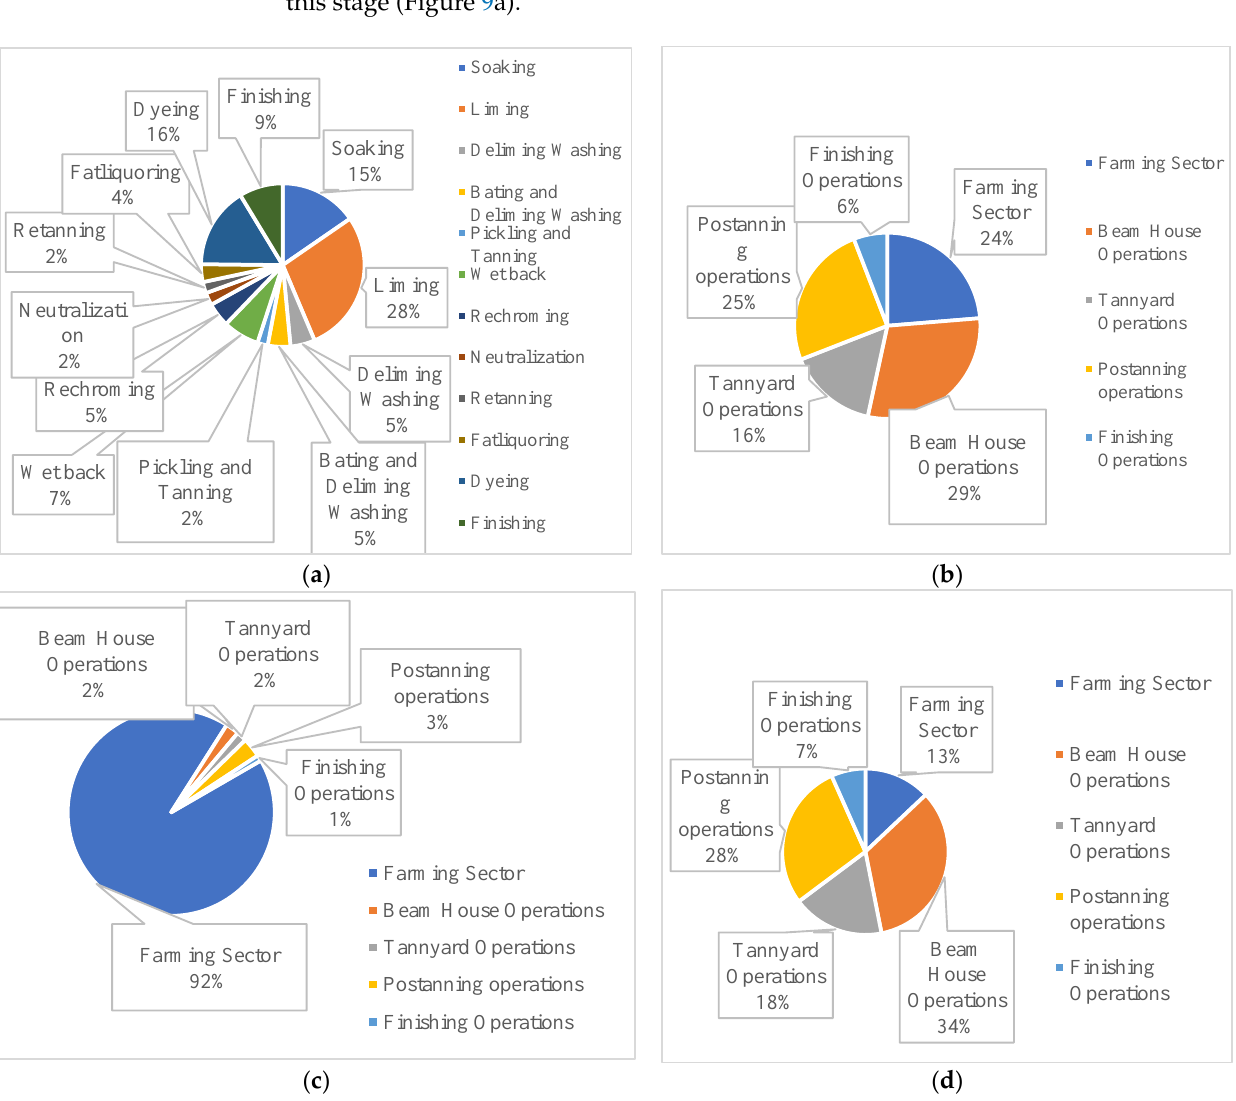
Figure 9. Water footprint analysis for farming and leather processing stages. ( a ) Distribution (%) of total water footprint by different leather processing stages, ( b ) Contribution (%) of farming and leather processing operations in total water footprint, ( c ) Contribution (%) of farming and leather processing operations in blue water footprint, ( d ) Contribution (%) of farming and leather processing operations in grey water footprint.